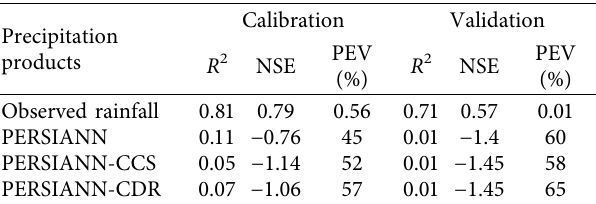
Figure 3: Simulated streamflow from hydrological modelling with inputs from different precipitation products: (a) for observed rainfall, (b) for PERSIANN, (c) for PERSIANN-CCS, and (d) for PERSIANN-CDR. Table 2: Hydrological model performance under different pre- cipitation data